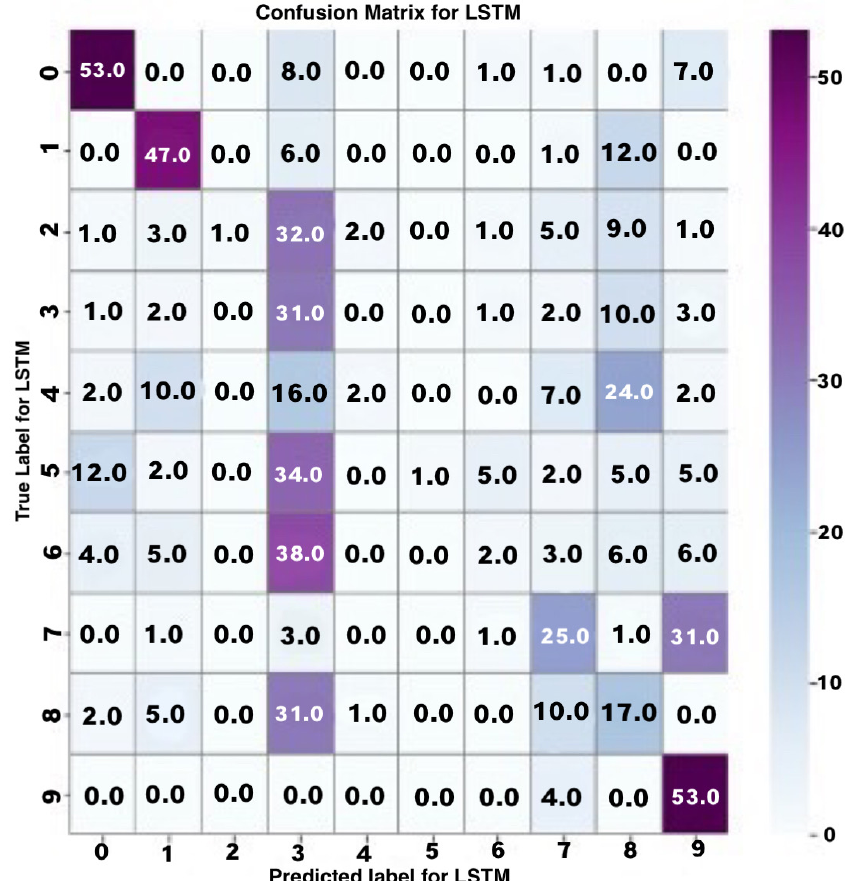
Figure 19. Confusion matrix for the LSTM